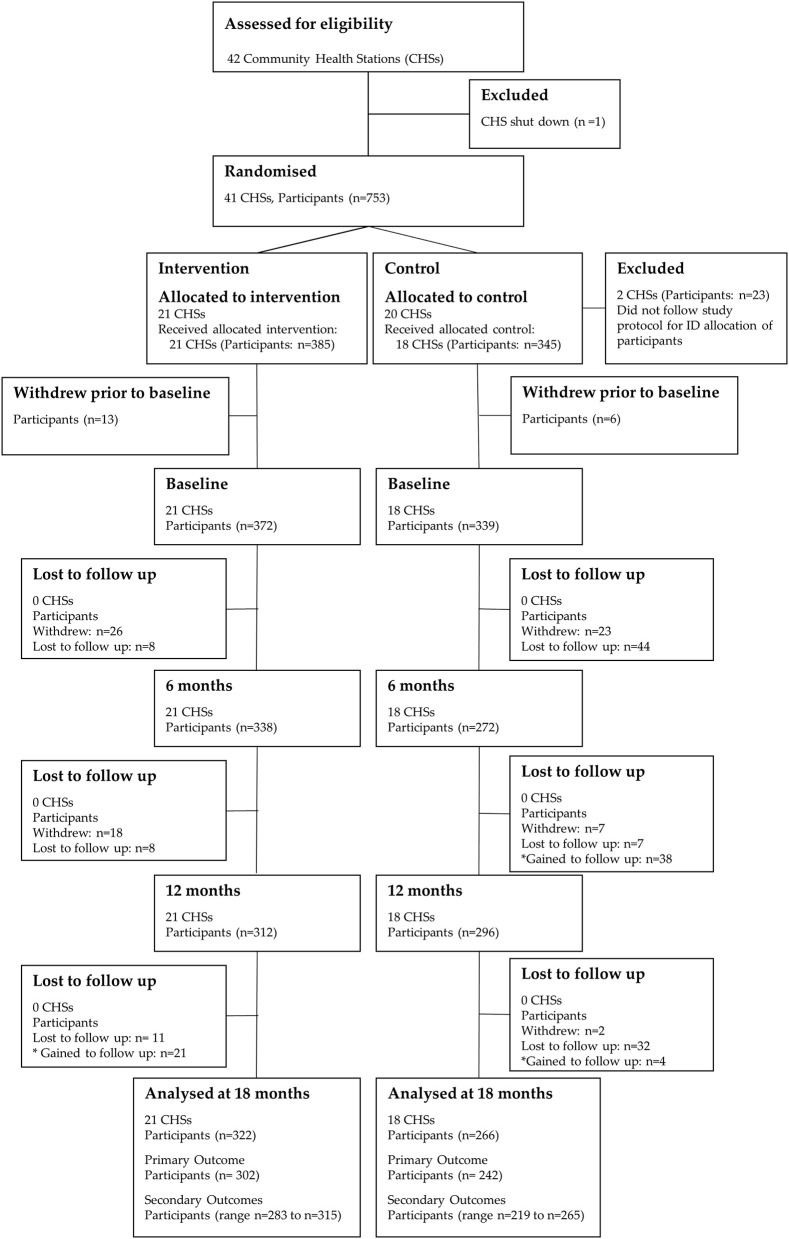
CONSORT flow diagram of community health stations and participants through the 18-month trial. Differences in the participant n values for the primary and secondary outcomes at 18-months are due to missing/invalid data.